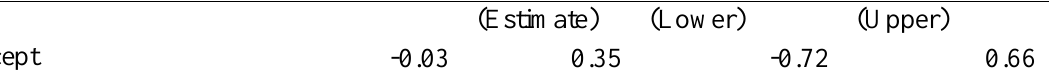
Table A3.E . Second-highest-ranking multi-season occupancy model (AIC ∆ AIC =1.61, AIC weight=0.15) for Western Meadowlarks along 47 transmission line study sites c